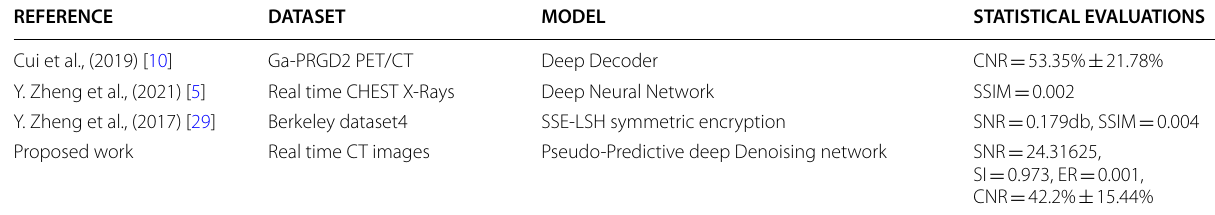
Table 2 Comparison of existing implementations and proposed